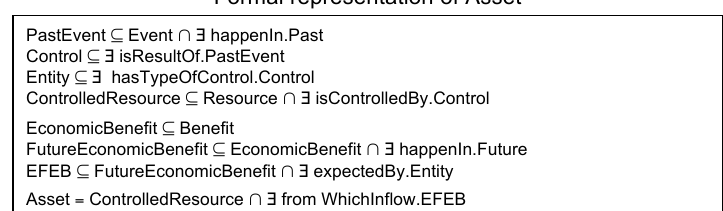
Formal representation of